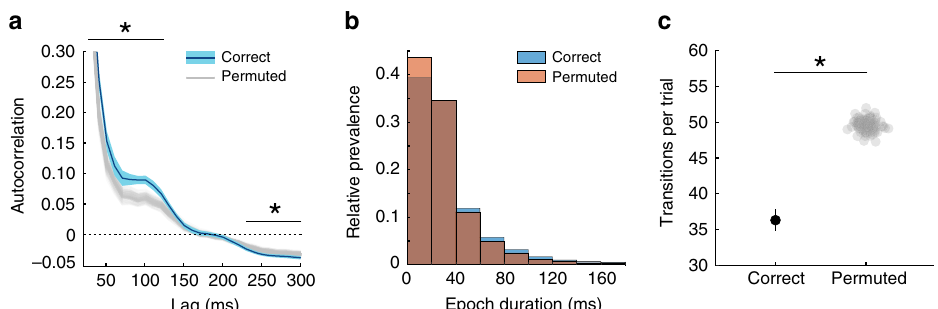
Fig. 3 Temporal structure of the reconstructed representations. a Autocorrelation of the reconstructed probabilities (dark blue line) and its s.e.m. (light blue shade) obtained from n = 21 participants, against the mean autocorrelation obtained by repeating the entire analysis ( n = 21) 100 times after randomly permuting the class labels (grey transparent lines). Stars indicate the time lags at which the autocorrelation differed from chance (two-sided cluster-level permutation test, p < 0.010). b Distribution of the duration of steady outcome representation epochs (blue) against the null distribution derived from permuted classi fi ers (red; two-sample Kolmogorov – Smirnov test, p < 0.001). c Consistently with the epoch durations in b , number of transitions between most likely outcome over the 1500 ms deliberation interval is lower than chance (permutation test, p < 0.010). The error bar represents the s.e.m. of the number of transitions for the correct classi